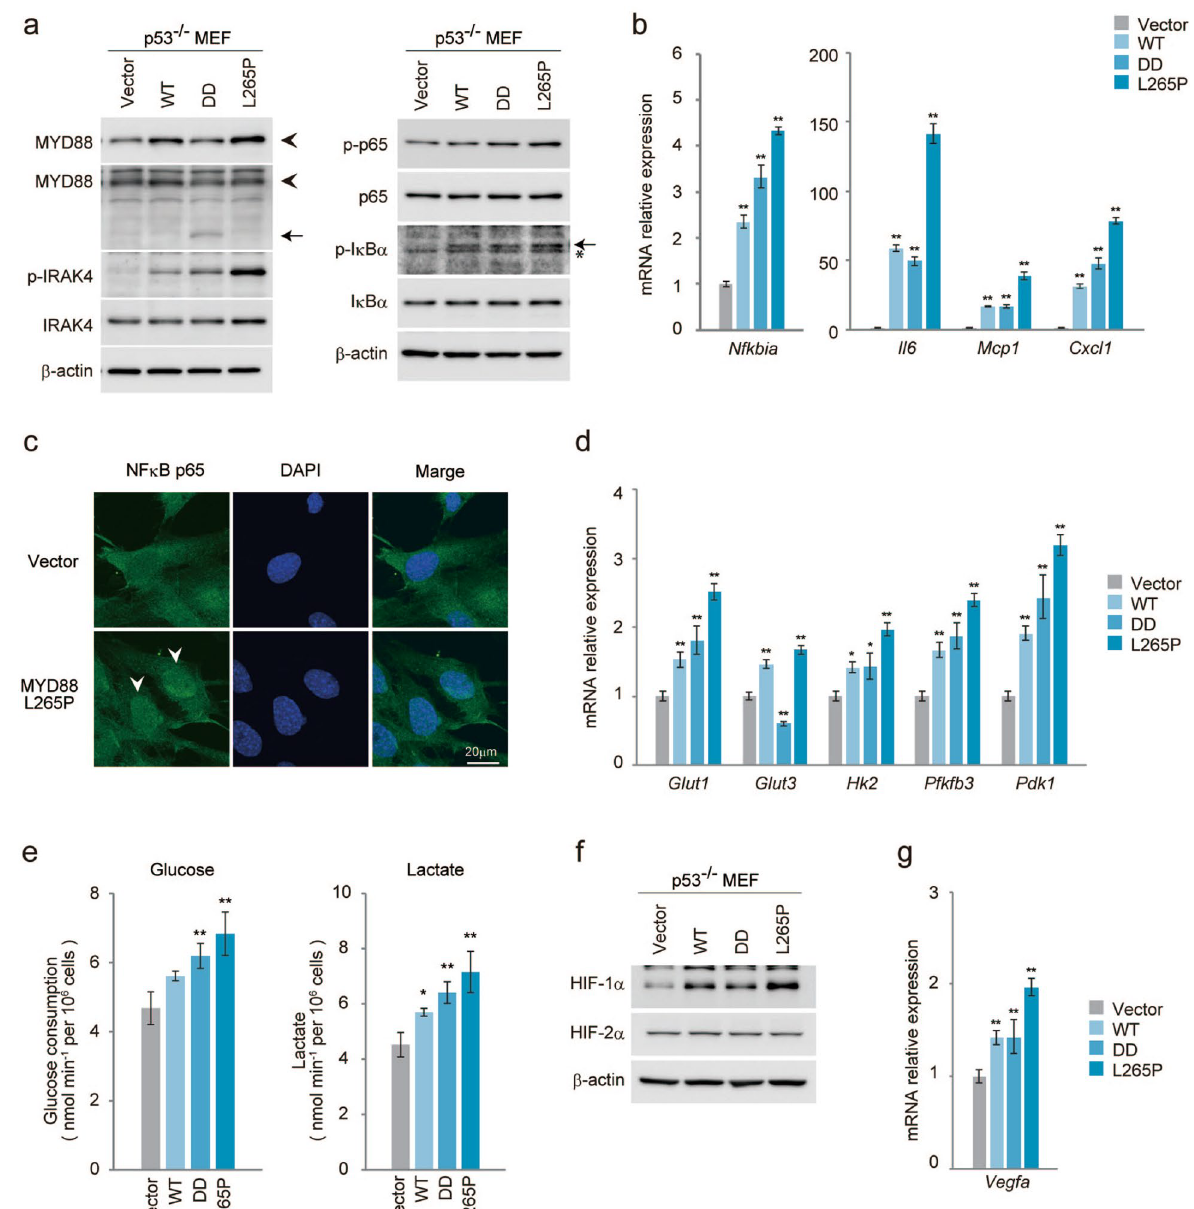
Figure 1. MYD88 signals activate NF-κB p65 and glucose metabolism in p53 −/− MEFs. The indicated MYD88 constructs were introduced to p53 −/− MEFs by retroviral infection. ( a ) Total cell lysate was analysed by immunoblotting. Left panel: The arrowhead indicates MYD88 and the arrow indicates truncated MYD88 (DD). Right panel: The arrow indicates phosphorylated-IκBα and the asterisk indicates a nonspecific band. All images of the original blots are shown in Fig. S9. ( b ) Quantitative polymerase chain reaction (qPCR) of NF-κB target genes. ( c ) Immunofluorescence staining shows NF-κB p65 nuclear localisation. Scale bar, 20 μm. ( d ) Expression of glucose metabolism-related gene mRNAs quantified by qPCR. ( e ) Glucose uptake and lactate production were measured. Statistical analysis was performed using one-way ANOVA followed by Scheffe’s F test. The quantified results are presented as the mean ± s.d. (n = 4). *P < 0.05, **P < 0.01 as compared with Vector. ( f ) Total cell lysates were analysed by immunoblotting. ( g ) Expression of vegfa mRNA was measured by qPCR. ( b , d , g ) The y-axis values are the relative fold change for gene transcripts normalised to β-actin. The data represent the mean ± s.d. (n = 3) using one-way ANOVA followed by Scheffe’s F test. *P < 0.05, **P < 0.01 as compared with